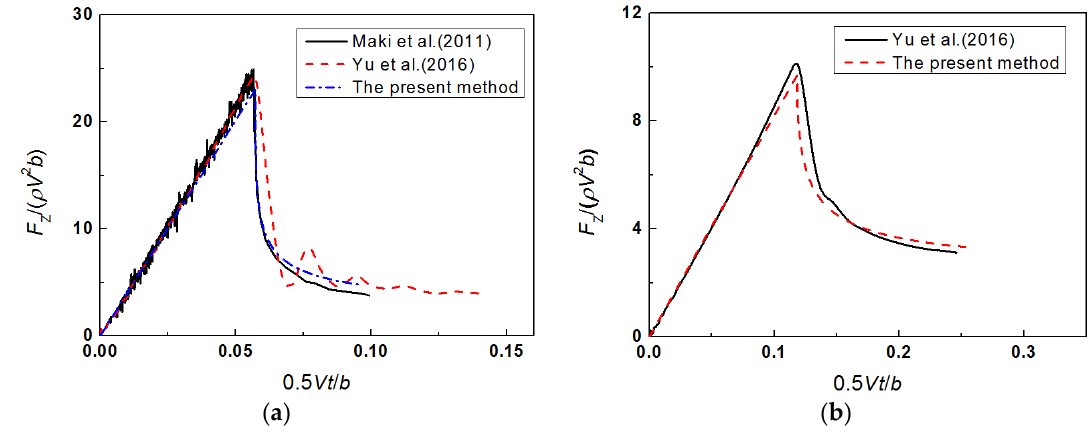
Figure 6. Comparison of the impact force in the stages before and after the flow separation. ( a ) 10° deadrise angle; ( b ) 20° deadrise angle.